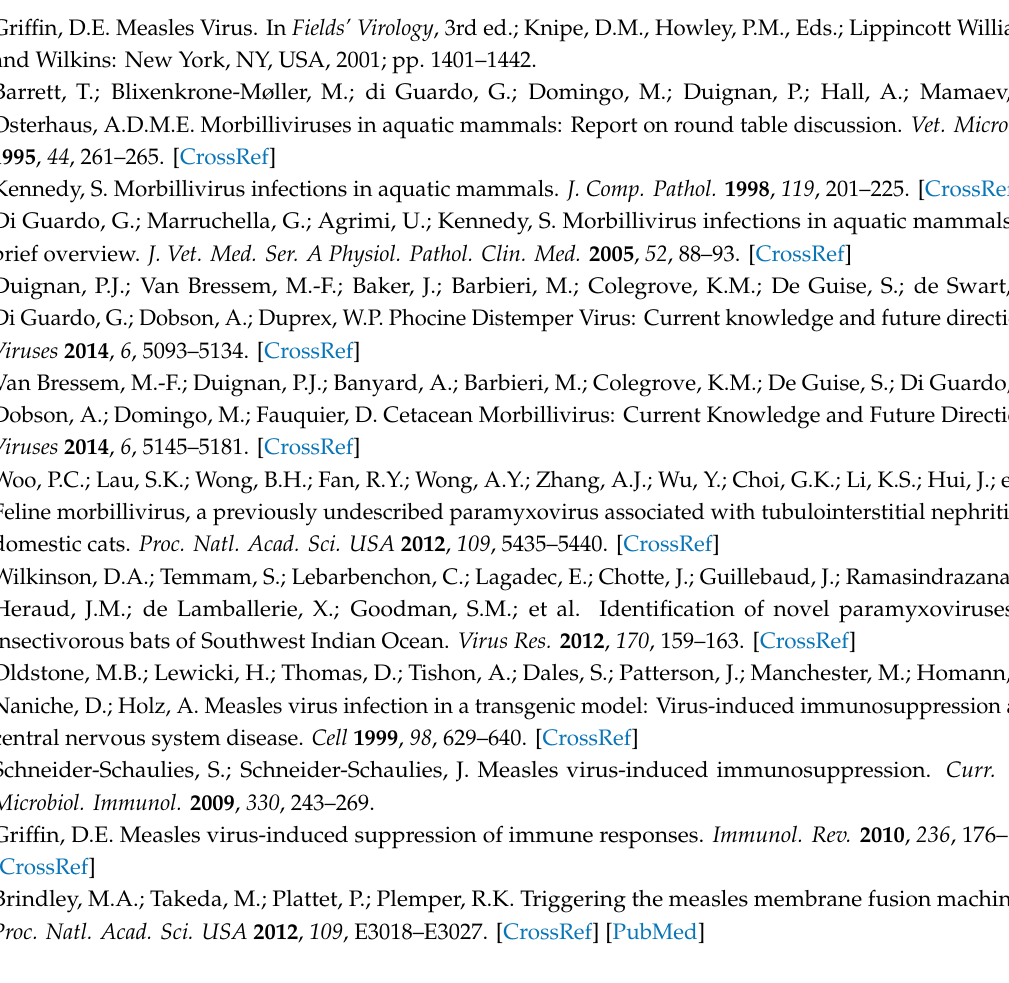
Table S1: Deduced amino acid sequences of SLAM V domains in pinnipeds and related Carnivore species; and Table S2: Deduced amino acid sequences of SLAM V domains in Cetacean species and